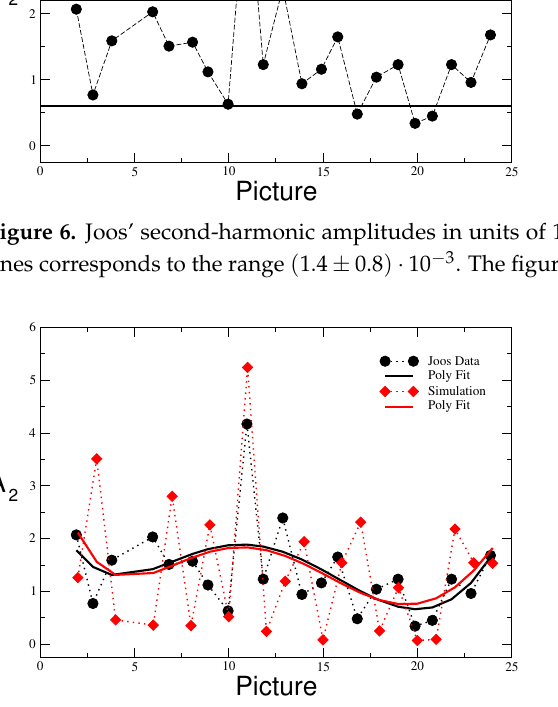
Figure 7. Joos’ second-harmonic amplitudes (in units of 10 − 3 (black dots)) are compared with a single simulation (red diamonds) at the same sidereal times as those in Joos’ observations. Two fifth-order polynomial fits to the two sets of values are also shown. The figure is taken from [37]